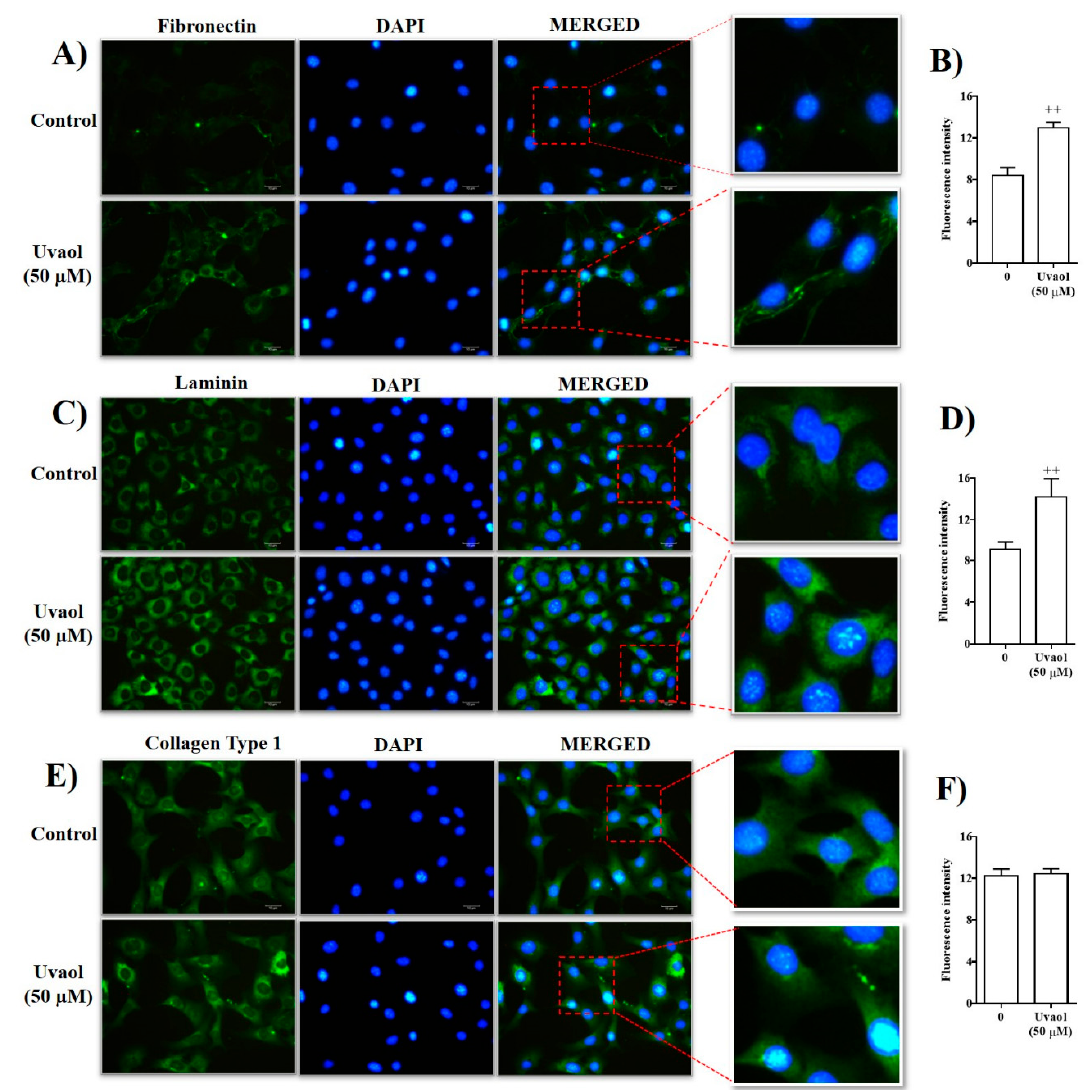
Figure 4. Effect of uvaol on the levels of fibronectin, laminin, and collagen type I in fibroblasts using immunofluorescence analysis. Fibroblasts were cultured with and without 50 µM uvaol. After 24 h, the cells were fixed and the extracellular matrix was immuno-stained using antibodies against fibronectin ( A ), laminin ( C ), and collagen type I ( E ). Nuclei were stained with DAPI. Each panel shows an image of one representative field from three independent experiments. Graph showing the results of the quantification of extracellular matrix synthesis of images from the respective panel ( B , D , F ). The image is displayed at × 400 original magnification and the red box indicates the region acquired for the quantification of extracellular matrix. Bars represent mean ± SD of three independent experiments. Statistical significance between groups was determined by ANOVA followed by Bonferroni’s test. (++) p < 0.01 compared with respective medium-treated group.